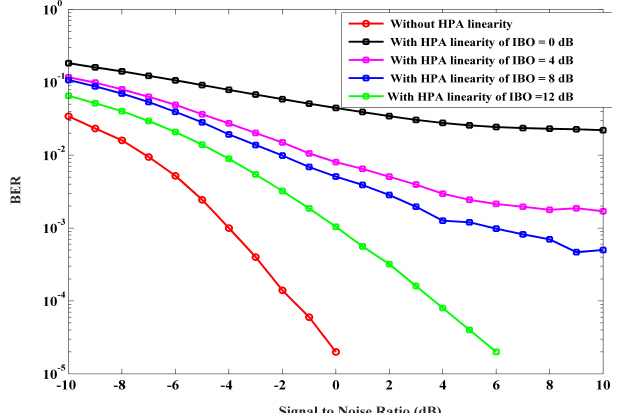
Figure 19. BER performance of the considered system with and without implementation of IBO-based HPA for the case of user 1.